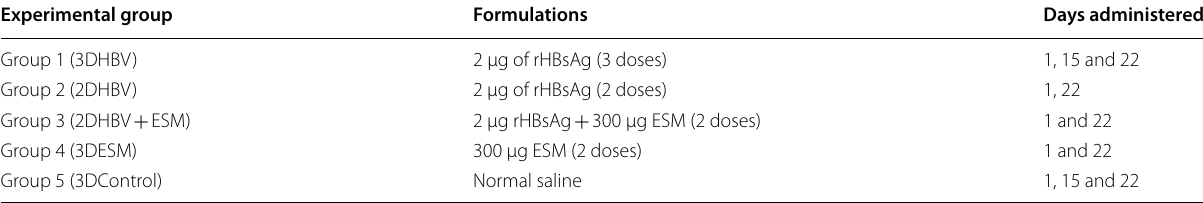
Table 1 Experimental designs showing the several formulations administered to the various experimental groups Experimental